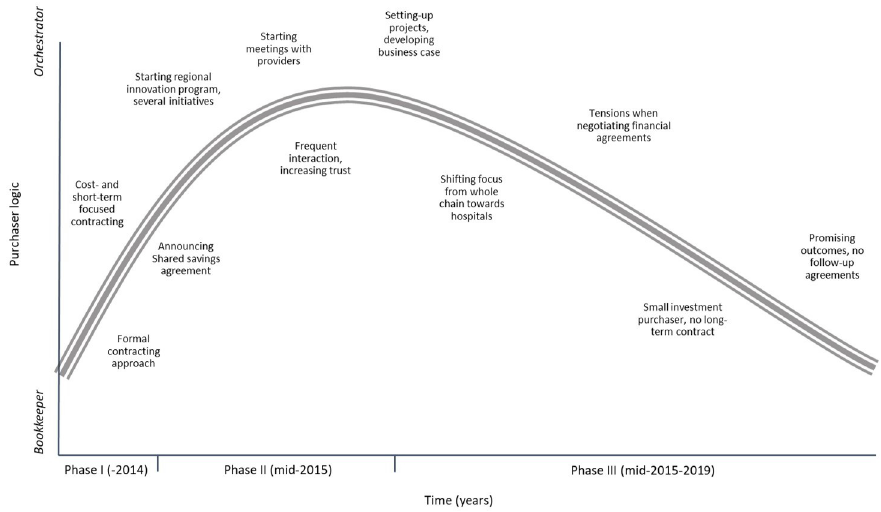
Fig 1. The emergence of the orchestrator’s logic and falling back into the bookkeeper’s logic.